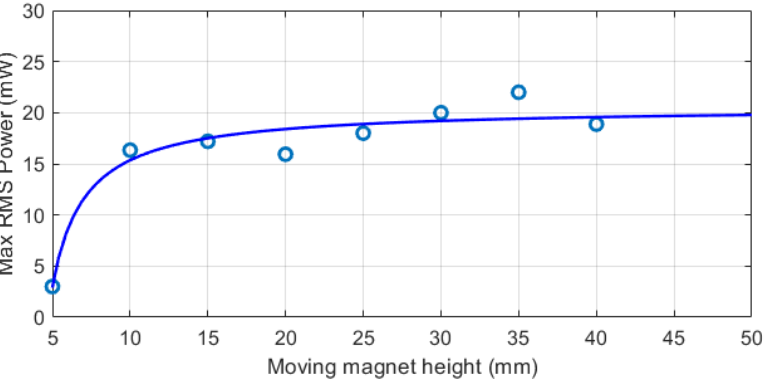
Figure 13. Moving magnet sensitivity analysis.